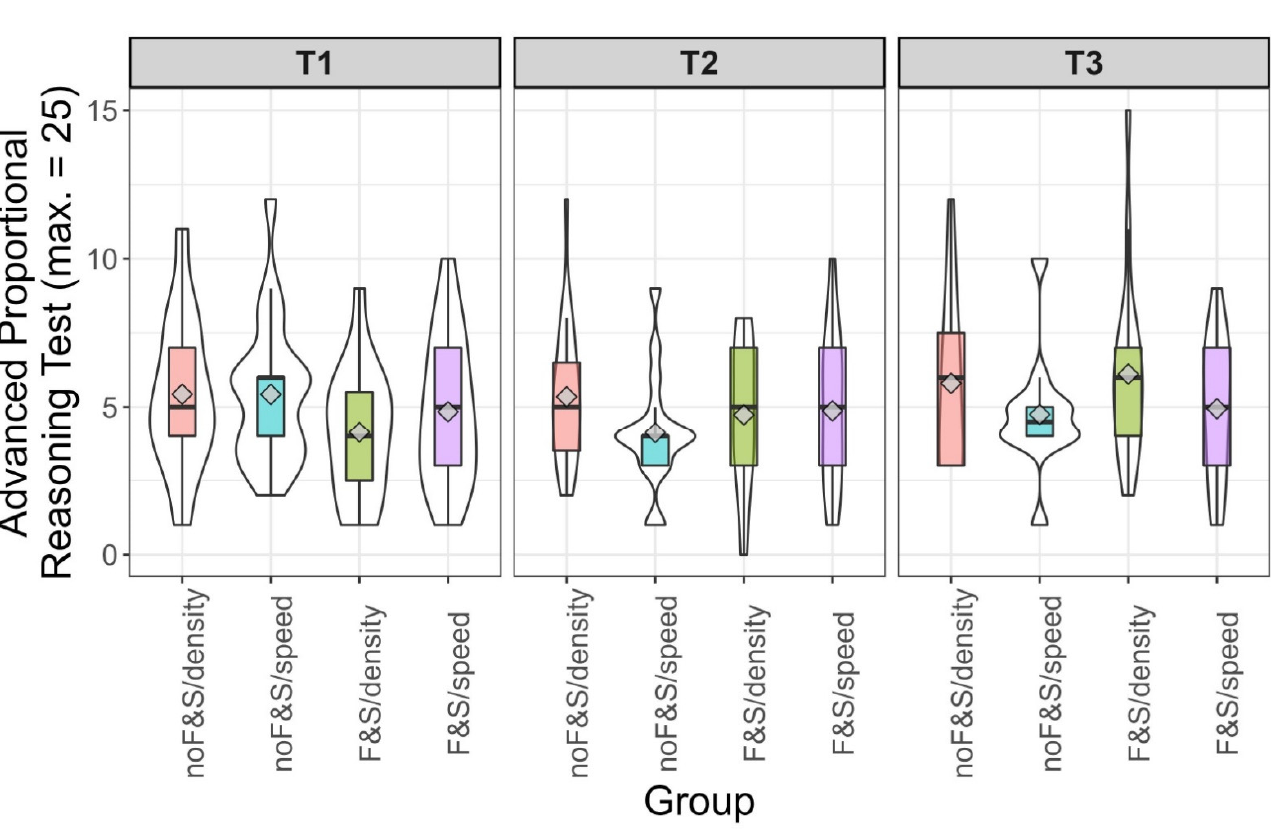
Figure 3. Score on the advanced proportional reasoning test by intelligence tercile and group in Study 1. Violin plots (white) and boxplots (colored). The diamond depicts the mean value per group. Table 2. Bivariate correlations in Study